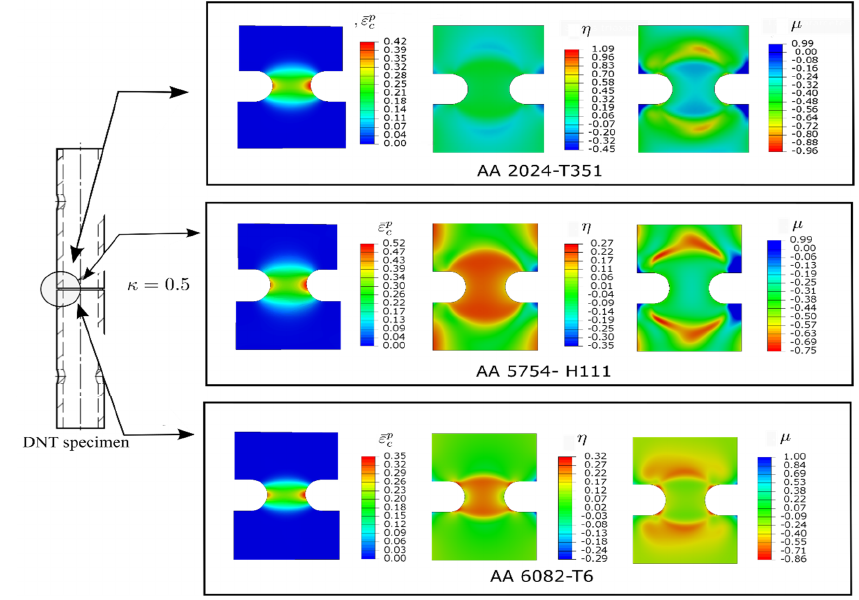
Figure 4. Contour plot of plastic strain at failure, stress triaxiality and Lode parameter in the notch region for the three different aluminum alloys.